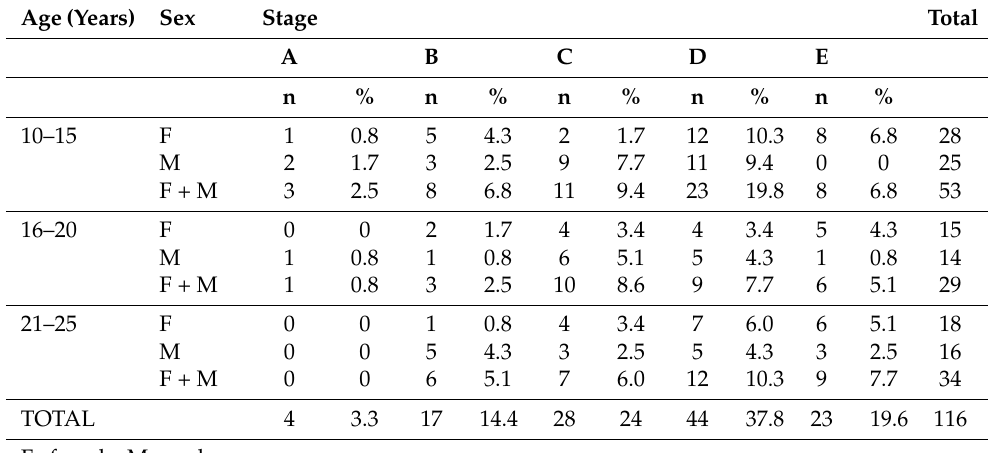
Table 1. Distribution of the MPS maturational stages by age group and sex.